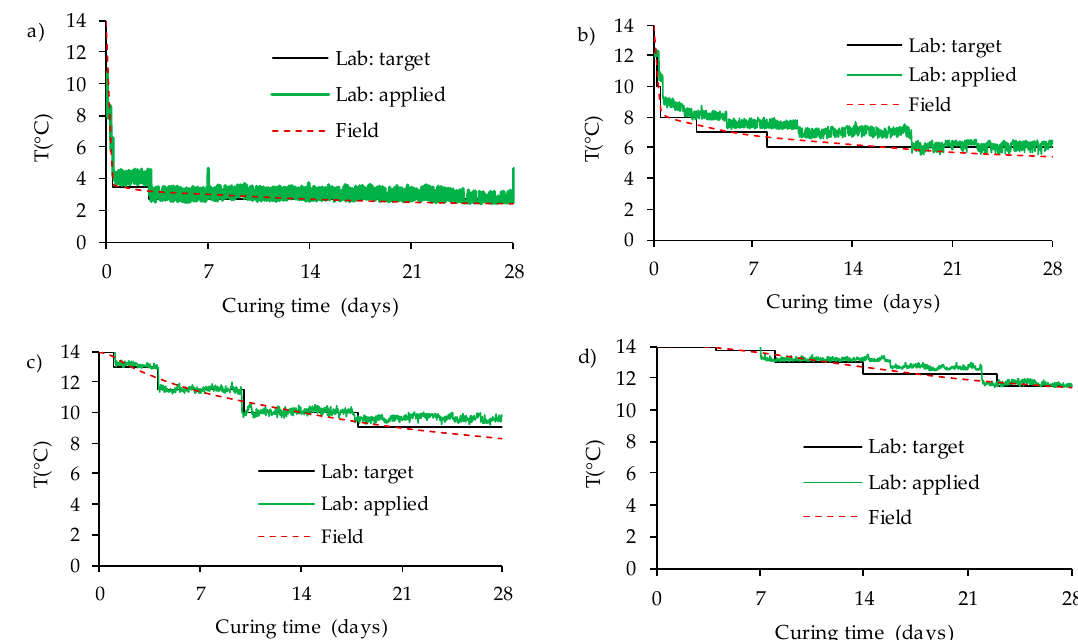
Figure 1. Variation over time in curing temperature estimated with COMSOL (Beya, et al. [25]), and targeted and applied in the laboratory for different distances from the CPB–rock wall interface: ( a ) 0 m, ( b ) 0.5 m, ( c ) 1 m, and ( d ) 2 m.